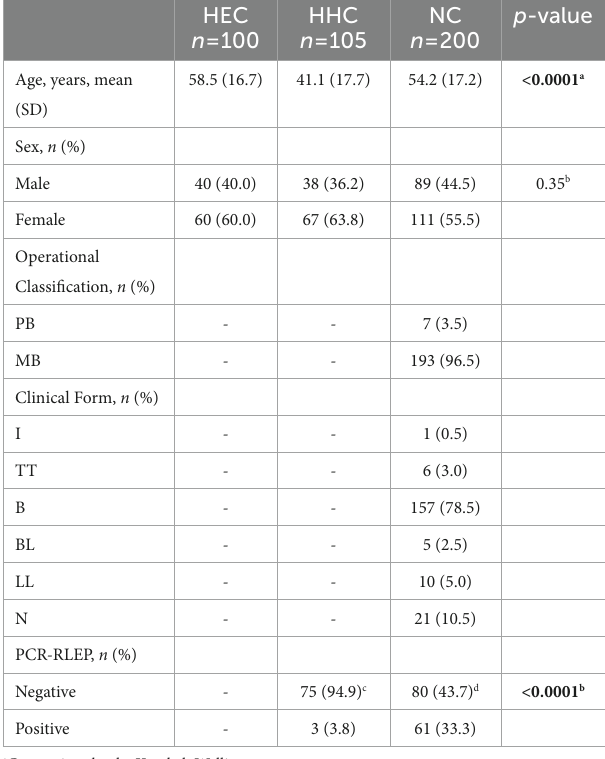
a Comparison by the Kruskal–Wallis test. b Comparison by the Chi-square test. c Data not available for 14 HHC. d Data not available for 53